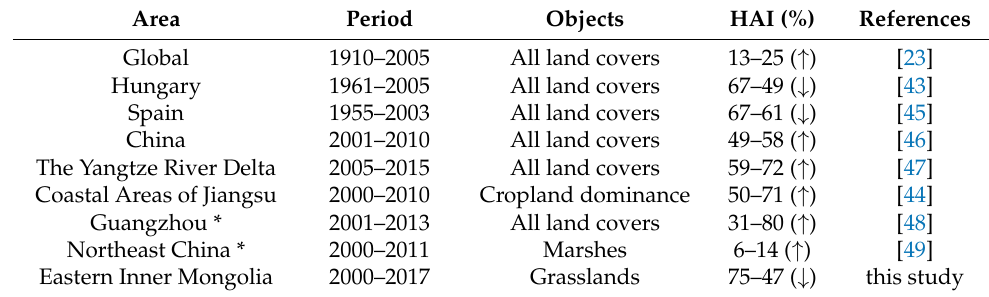
Table 2. Comparison of the HAI estimated in this study with previous studies.